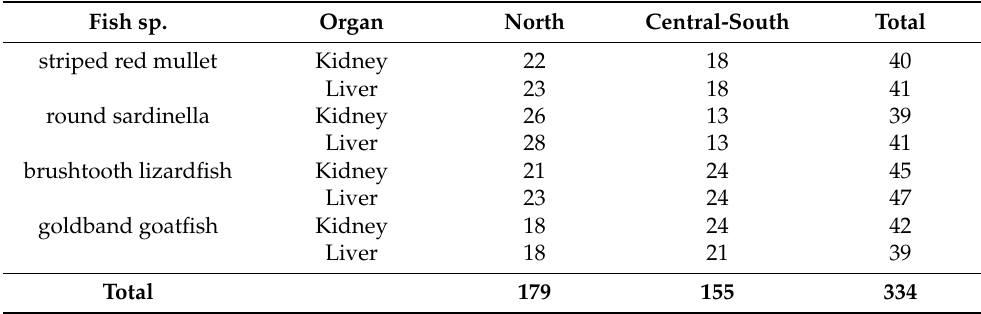
Table 1. A summary of the samples collected—divided between the regional origins of the fish, the sampled organ and fish species. Fish